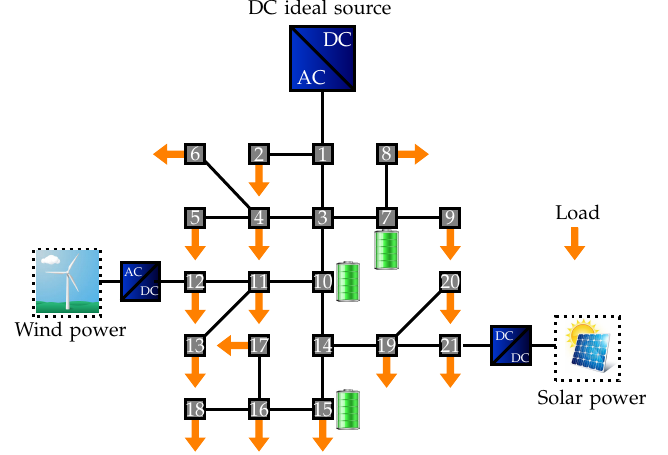
Figure 3. Test DCMG of the 21-node Table 2. Parameters for the 21-nodes